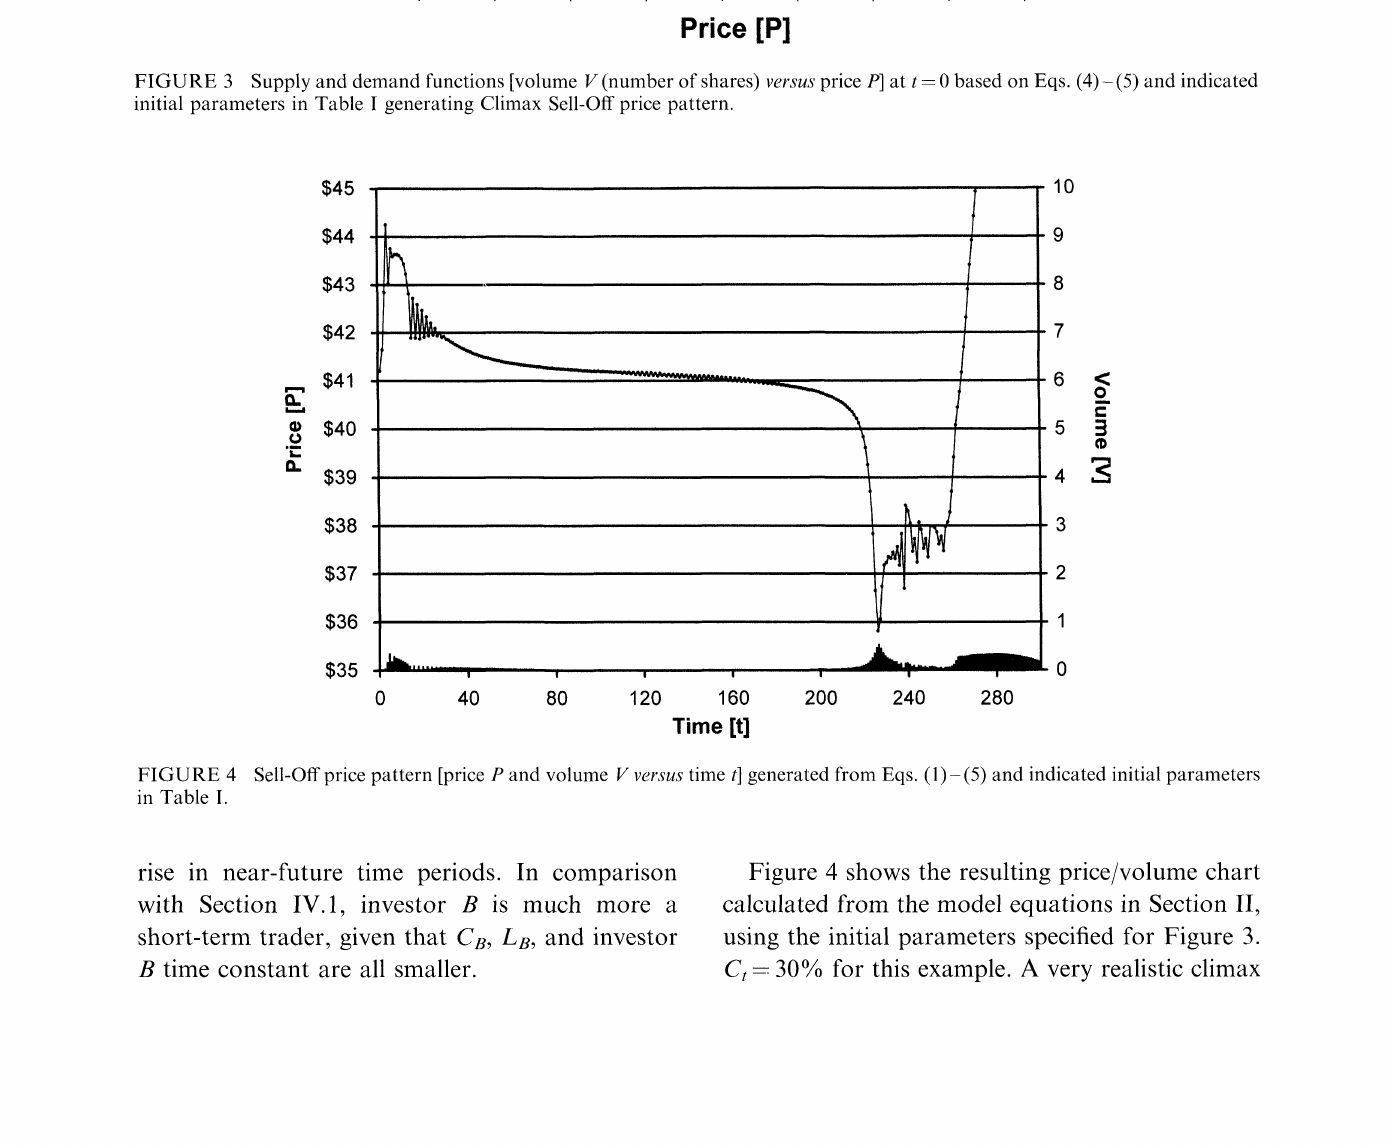
using the initial parameters specified for Figure 3.